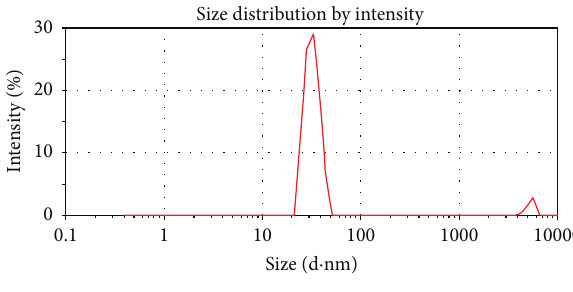
Figure 3: Particle size distribution of water phase nanosilver.